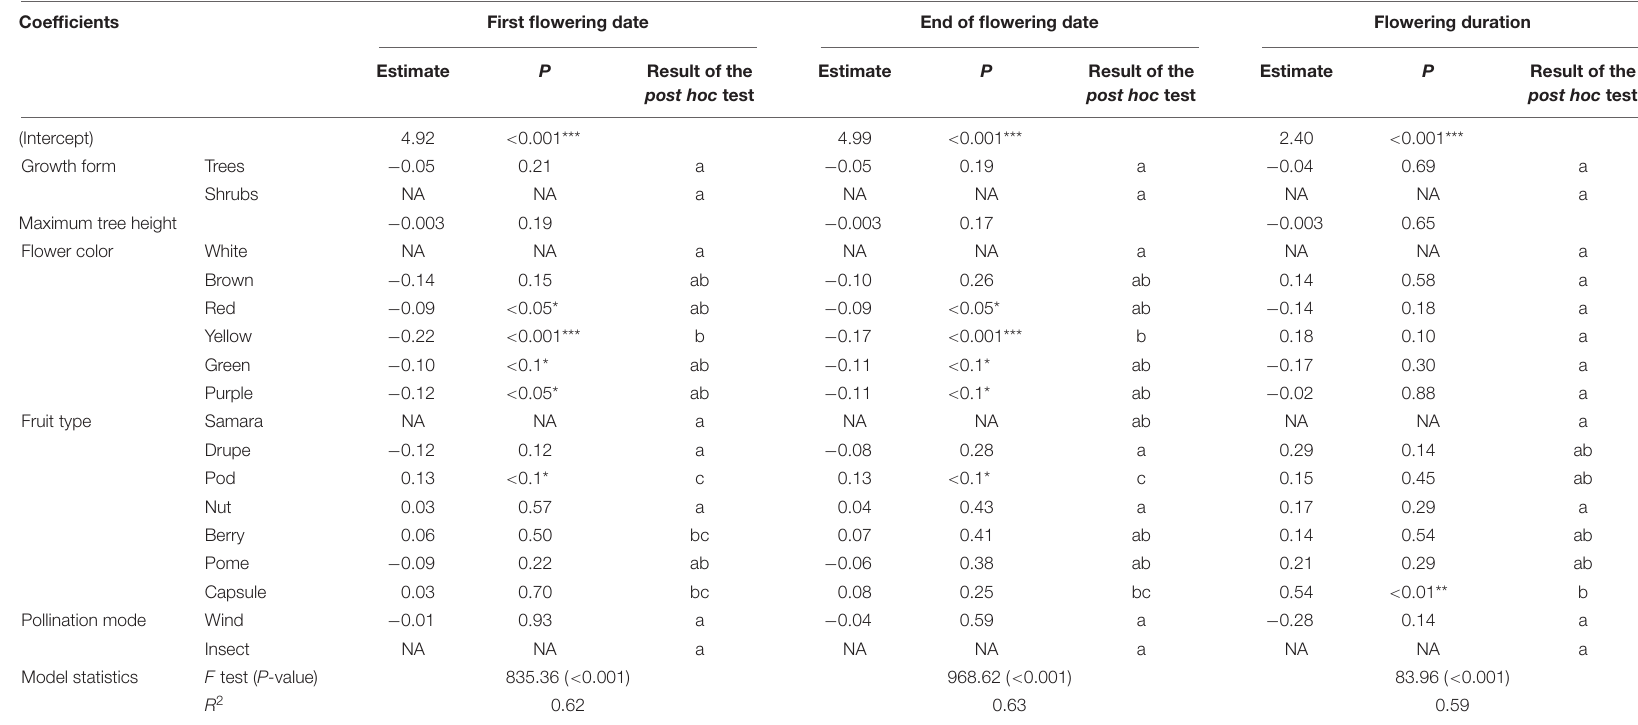
TABLE 1 | Difference in the influences of sub-categories of functional traits (i.e., maximum tree height, flower color, fruit type, and pollination mode) and growth form (i.e., tree and shrub) on the variation of three characteristics of flowering phenology among